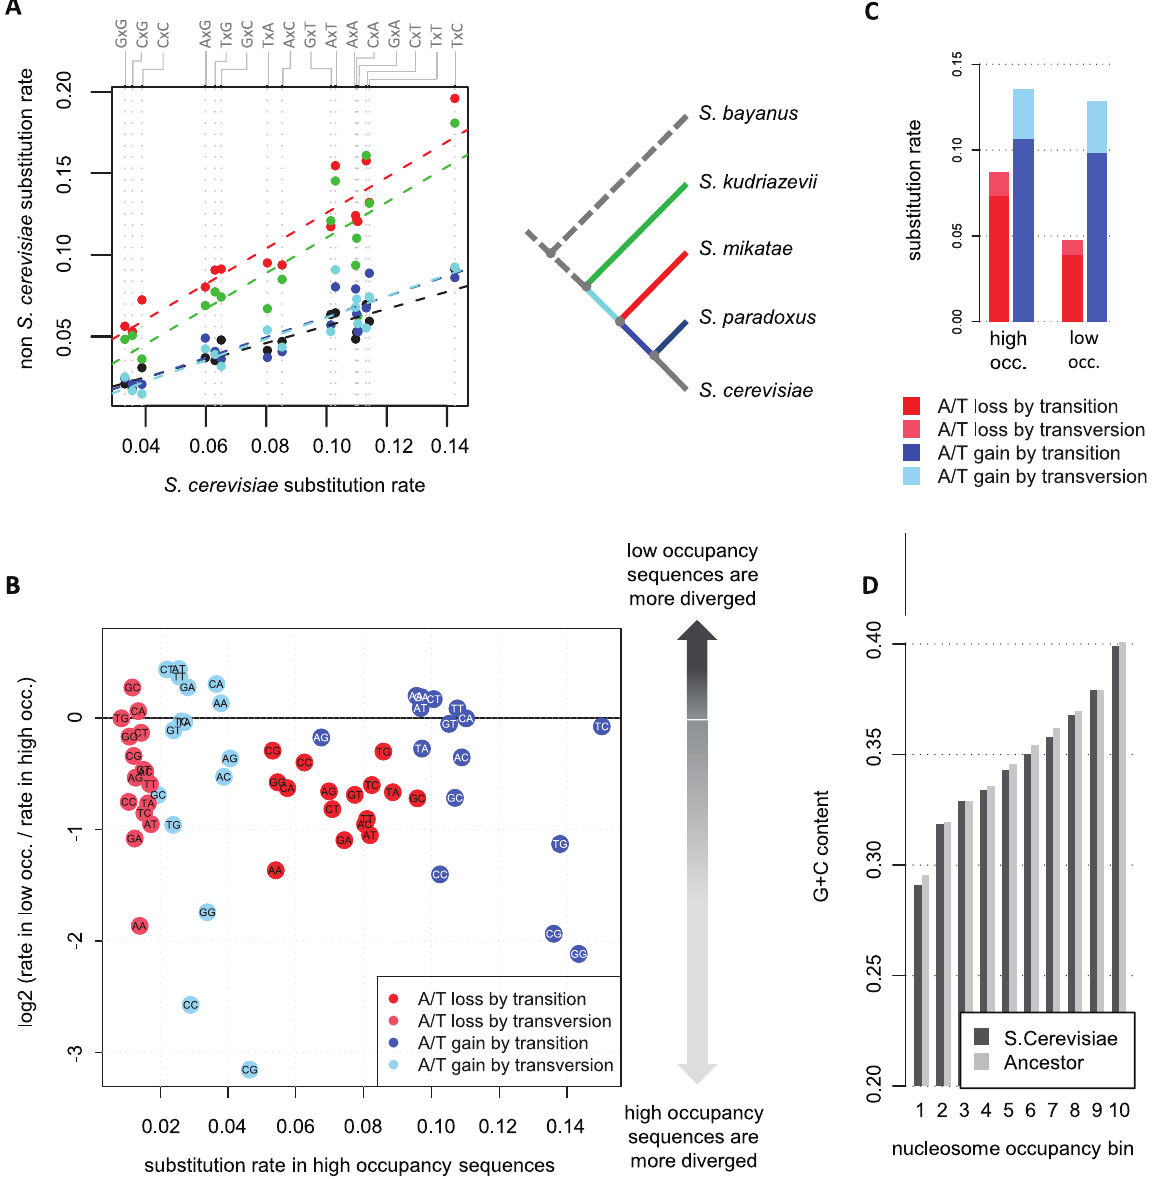
Figure 2. Low occupancy sequences lose A/T nucleotides slowly and gain them in a context-dependent fashion. A) Yeast substitution rates are robustly correlated with the flanking nucleotides. Shown are the inferred C to T substitution rates for the S. cerevisiae lineage (X-axis), and other sensu stricto lineages (color coded, Y-axis). Each point represents the C to T substitution rate in one of 4x4 different flanking nucleotide contexts which are defined using the 5 9 and 3 9 nucleotides depicted on top. The data reveal a four-fold variation in substitution rates at different contexts, which is consistent among the different lineages (as shown by the fit between the independently inferred substitution rates of S. cerevisiae and of the other lineages). Controlling for this variation is important when comparing substitution dynamics in A + T rich vs. A + T poor genomic regions, such as low and high occupancy sequences. B) Different evolutionary dynamics in low and high occupancy loci. Shown are log-ratios of substitution rates in low vs. high occupancy sequences (Y-axis) plotted against the substitution rates at high occupancy sequences (X-axis). Each point represents the rate of one of four types of substitutions (color coded) in loci flanked by the 5 9 and 3 9 nucleotide depicted inside the data point. Substitutions in reverse complementary contexts are averaged and shown only once. A/T-losing substitutions (red, pink) are , 45% slower in low occupancy loci, an effect that is observed independently for transitions and transversions across the different flanking sequence contexts. A/T-gaining substitutions (blue, cyan) are highly dependent on the context, with the main group having rates which are independent of the nucleosome occupancy and with A/T gains in G/C flanking contexts highly conserved in low occupancy sequences. C) Averaged substitution trends. Shown are overall rates of A/T-gaining and A/T-losing substitutions in high and low nucleosome occupancy (occ.) averaged over all contexts. The simplified divergence pattern is difficult to explain using standard models of selection, since different types of substitution are differentially affected. D) The S. cerevisiae lineage maintained the G + C content of low and high occupancy sequences. Shown are the average G + C content in the extant S. cerevisiae genome and in the inferred common ancestor of S. cerevisiae and S. paradoxus , depicted for 10 levels of S. cerevisiae nucleosome occupancy (Methods). The analysis suggests that the highly variable substitution rates shown in B are not driving divergence in net G + C content but take part in a conservative process.